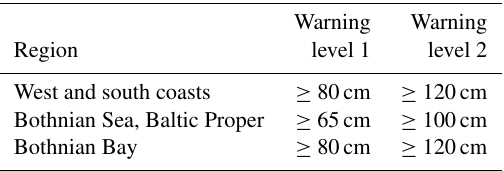
Table 8. Warning level for the Baltic Sea, Kattegat and Skagerrak used at the SMHI (Schöld et al., 2017). If sea level is predicted to be higher than or equal to a specific warning level, a public warning is issued. Warning levels are given relative to the mean sea